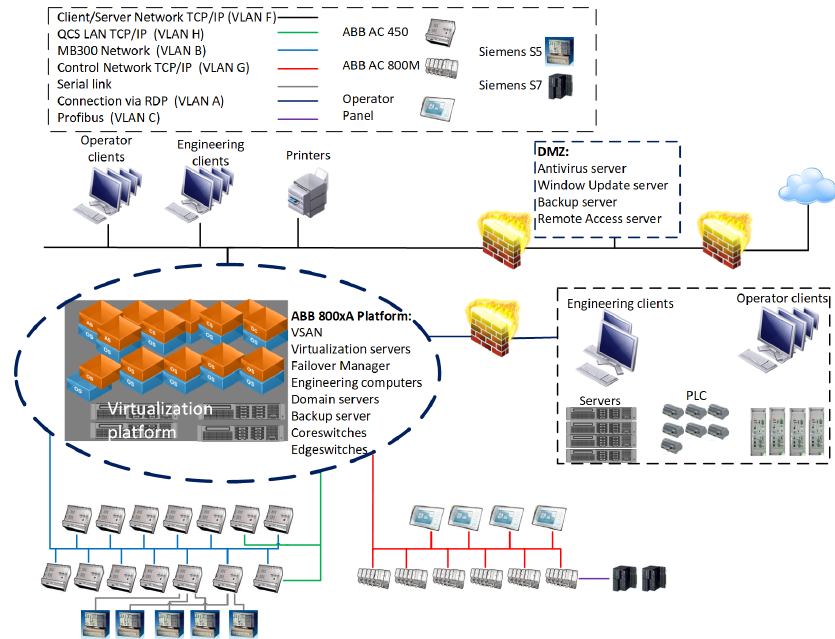
Figure 4. Network topology of one of the paperboard machines at